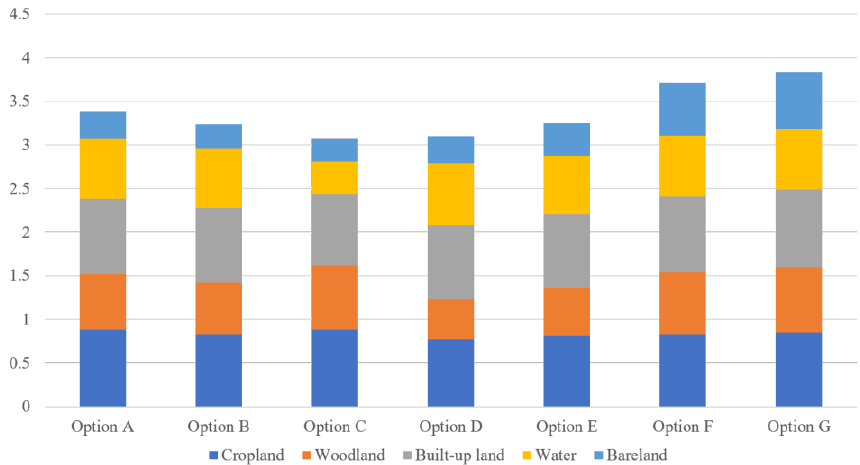
Figure 6. F1 scores for 2022. Figure 6. F 1 scores for